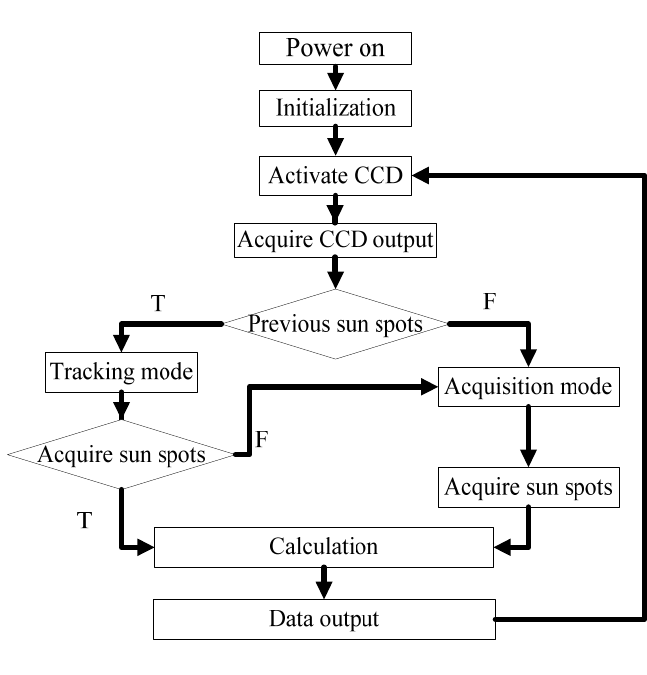
Figure 11. Program flowchart.